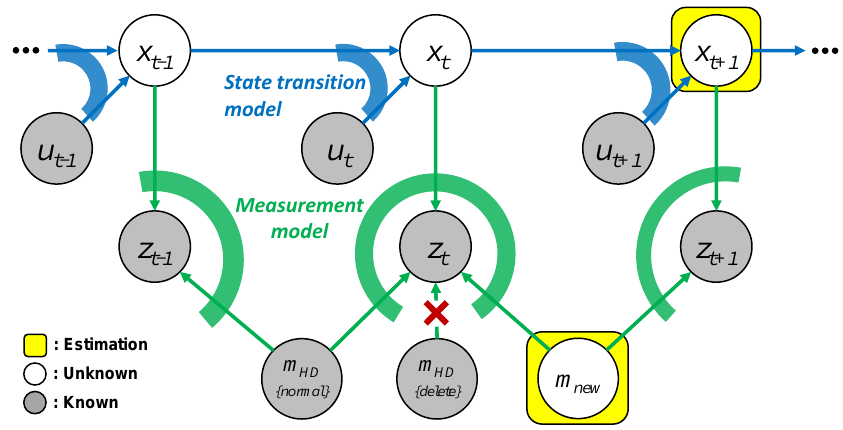
Figure 4. dynamic Bayesian networks (DBN) Graph representation of the